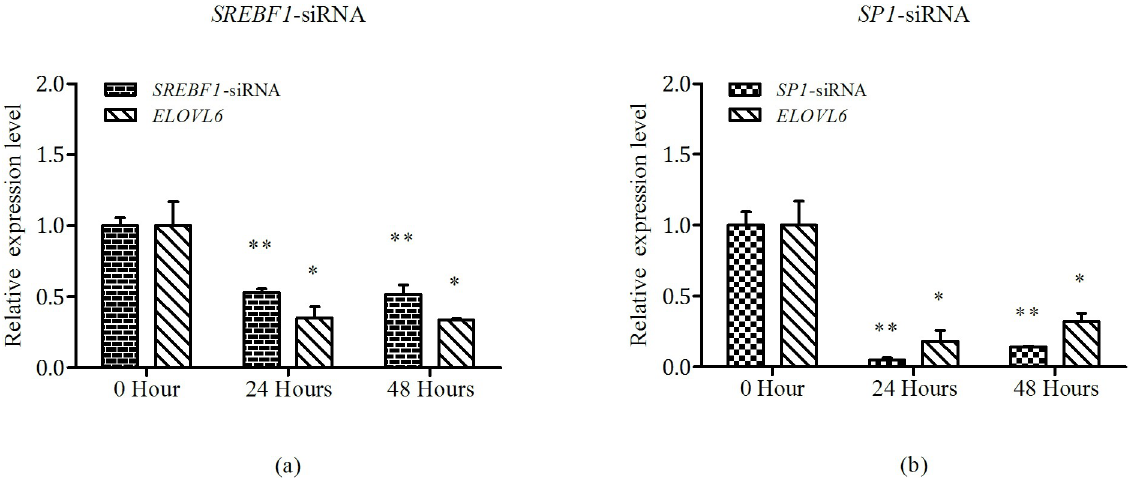
Fig 6. siRNA decreasedthe mRNA expression of ELOVL6 . ( a ) The silencingof SREBF1 affected the mRNA expressionof ELOVL6 ; ( b ) The silencingof SP1 affected the mRNA expressionof ELOVL6 . GAPDH was measured as the reference gene. Each column representedthe mean ± SD of the independentexperiment performed in triplicate. * p < 0.05; ** p < 0.01.